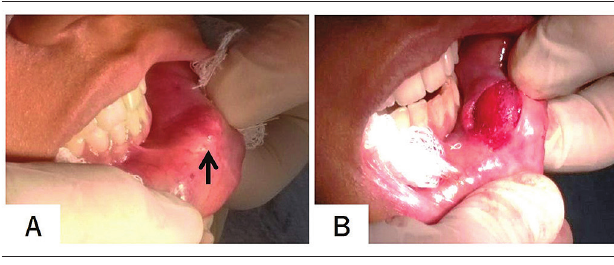
figurE 1 − Clinical aspect of the lesion A) clinical aspect of the lesion. Observe the small nodular sessile lesion, with color resembling the surrounding (arrow) mucosa in lower lip, on the left; B) aspect during surgery, revealing a well-delimited lesion on labial submucosa.